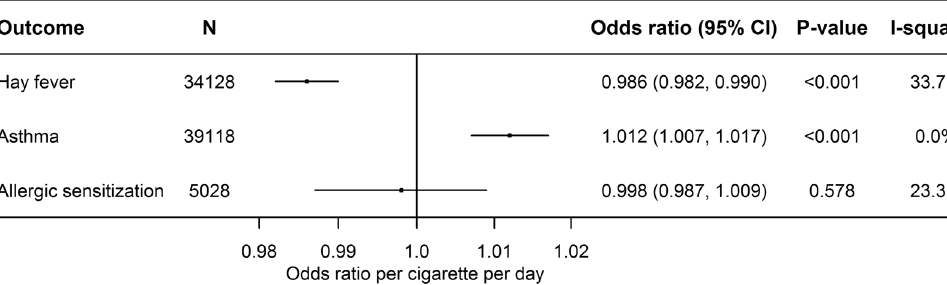
Figure 2. Age- and sex-adjusted associations of smoking heaviness with hay fever, asthma and allergic sensitization using fixed effect